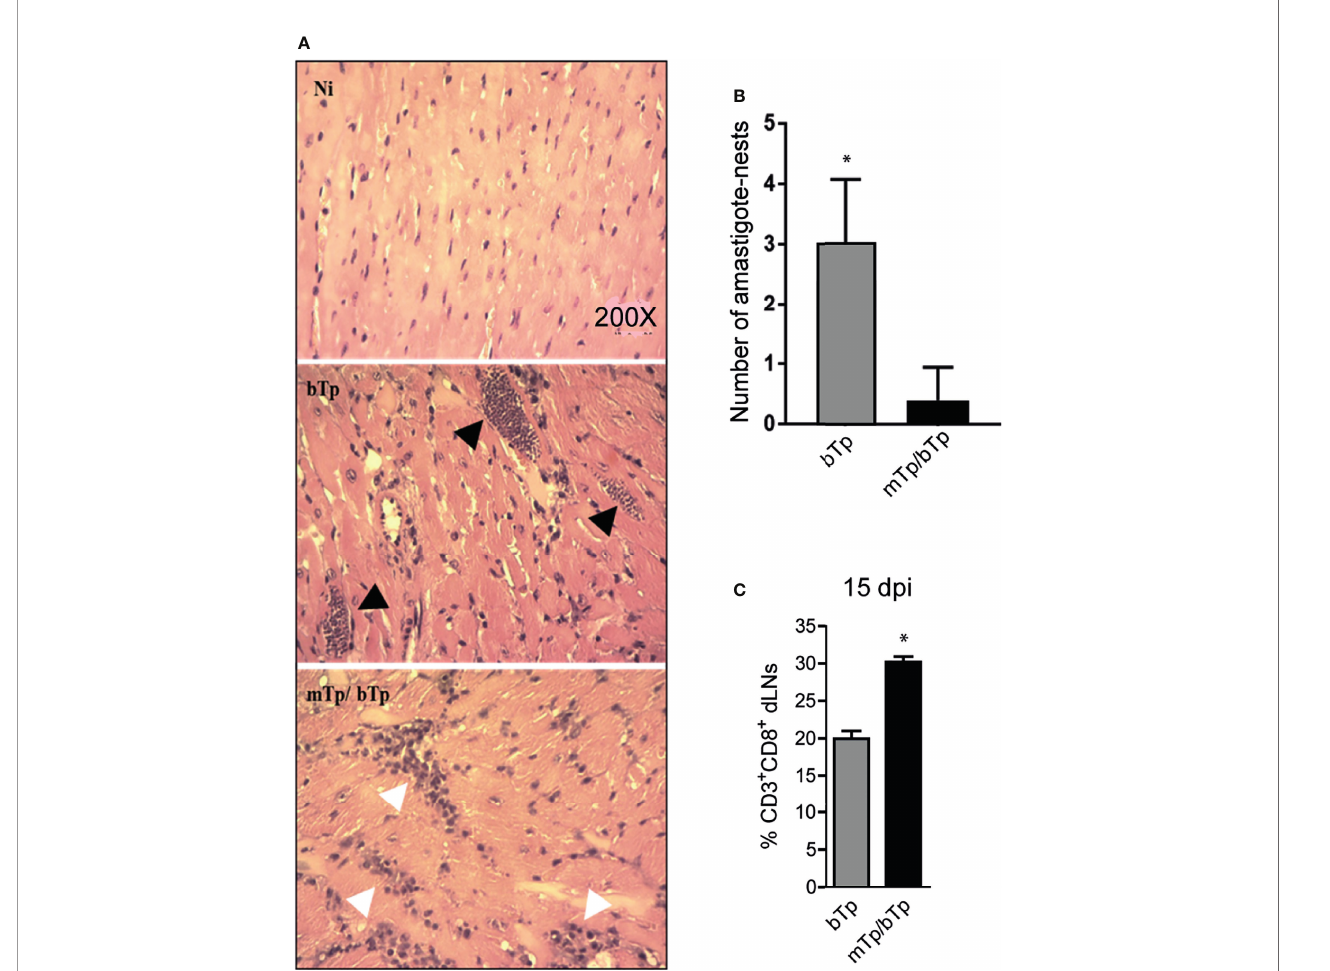
FIGURE 4 | mTp infection enables better control of the parasite load in the cardiac muscle of mice. (A) Histology of cardiac tissue from NI, infected with mTp or bTp, or challenged animals, stained with H&E. Black arrows show amastigote nests and white arrows show cellular in fi ltrates in tissue. (B) Number of amastigote nests in cardiac muscle from 25 random fi elds per sample, n = 3, 15 dpi. *p < 0.05 (one-tailed, unpaired Student ’ s t -test). (C) Frequency of CD3 + CD8 + T cells in dLNs at 15 dpi analyzed by fl ow cytometry. Bars represent the summary data of three independent experiments ( N = 3 with duplicates per treatment; mean + SEM). *p < 0.05 (one-tailed, unpaired Student ’ s t